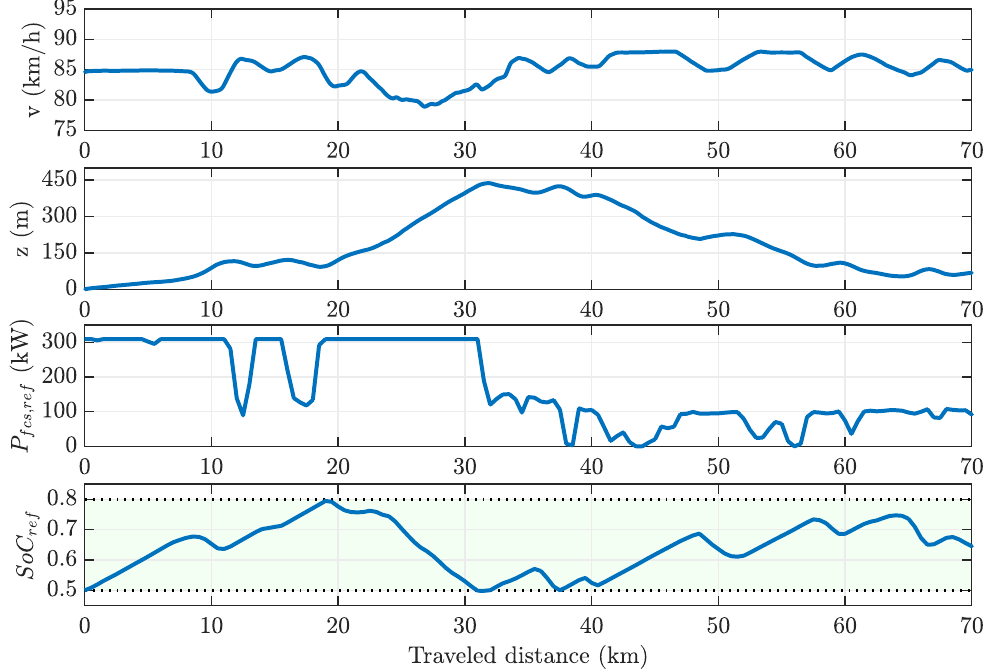
Figure 6. Optimal generation of predictive energy management references considering a driving cycle segment in which the fuel cell truck must overcome a hill. The figure shows speed, elevation, predictive FCS, and SoC